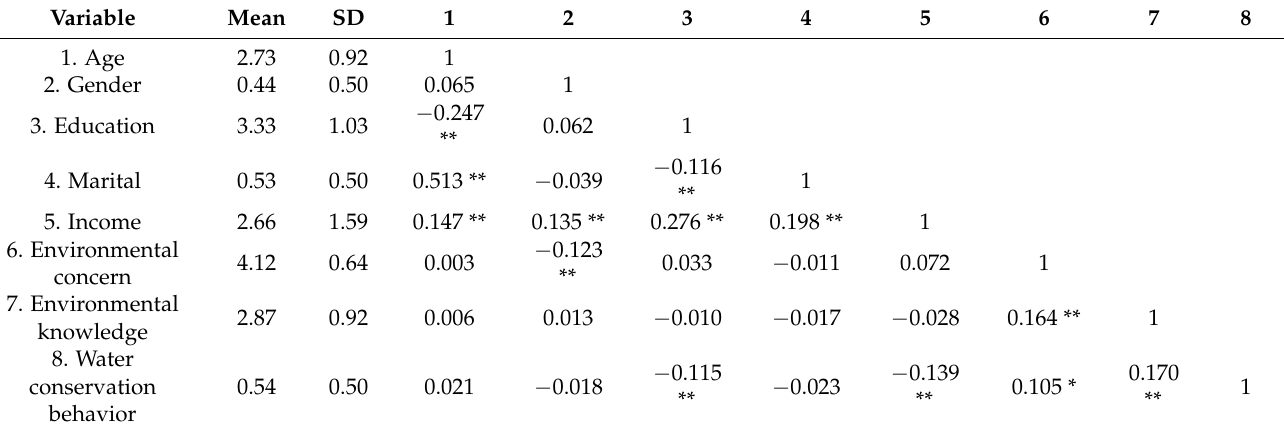
Table 1. Means, standard deviations, and correlation coefficients of the model variables (N = 532).